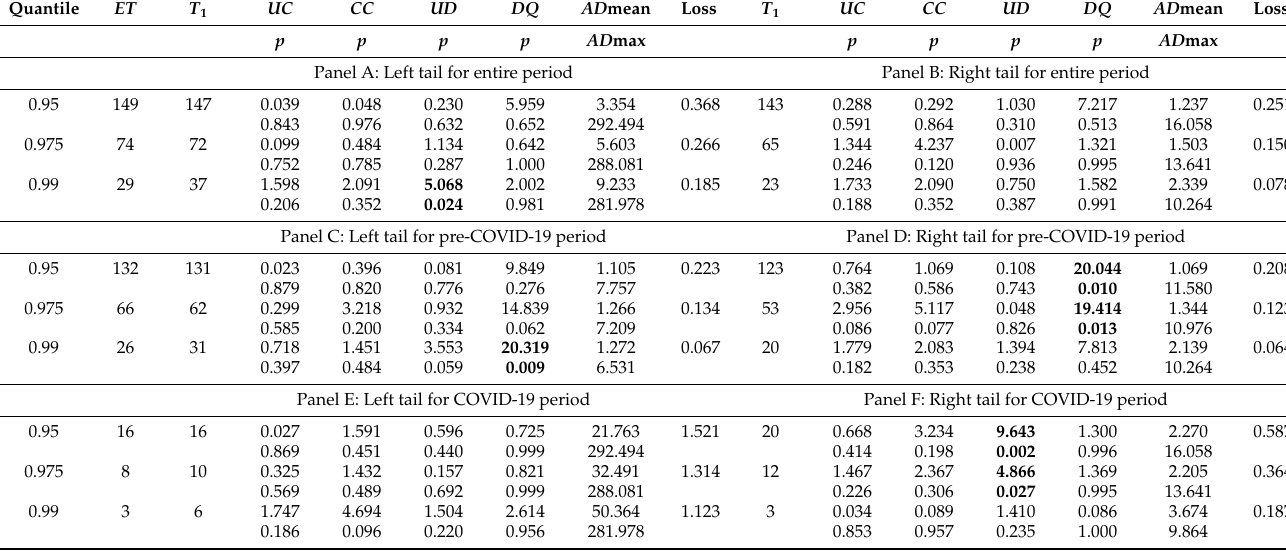
Table 6. Backtesting for VaRs based on the GARCH-EVT.